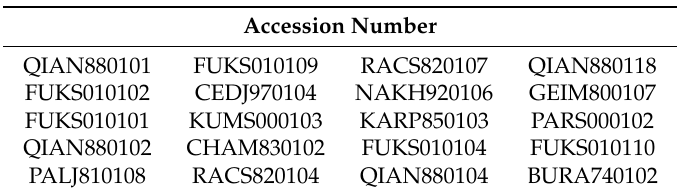
Table 1. The accession numbers of the 20 amino acid indices.